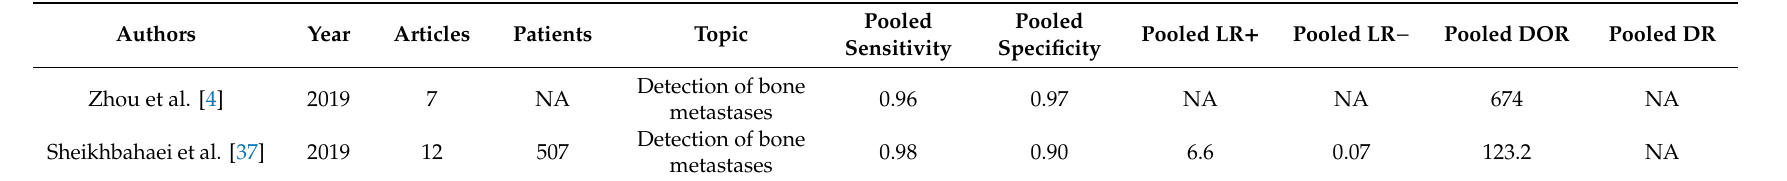
Table 5. Meta-analyses on fluoride PET / CT in prostate